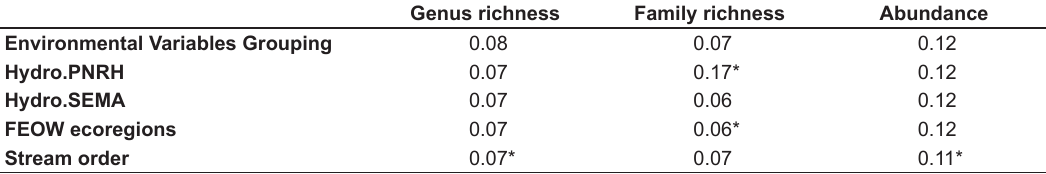
Table 3. Sum of Squares values for permutation test of genus and family richness and abundance (n = 37 streams).